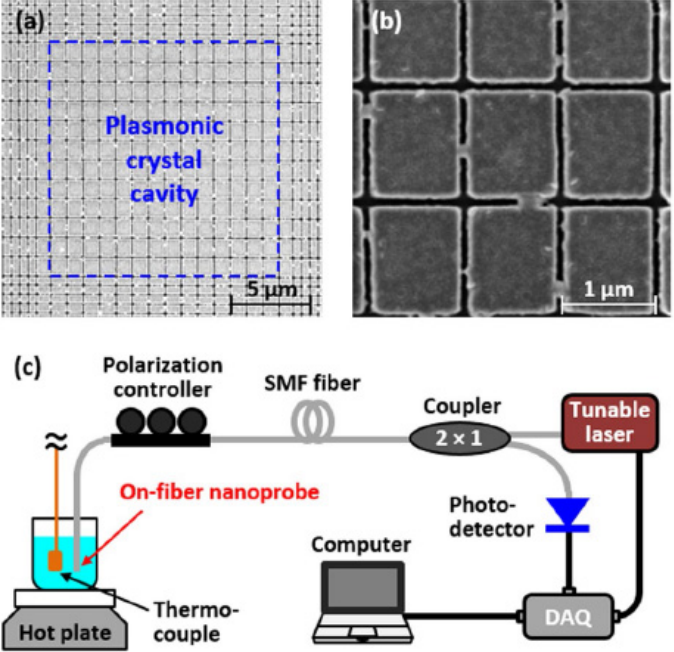
Figure 31. ( a ) SEM images of the plasmonic crystal cavity of the fabricated multiparameter nanoprobe; ( b ) SEM images of the 2D rectangular Au grating inside the plasmonic crystal cavity; ( c ) Schematic of the experimental setup. Reprinted with permission of [95].